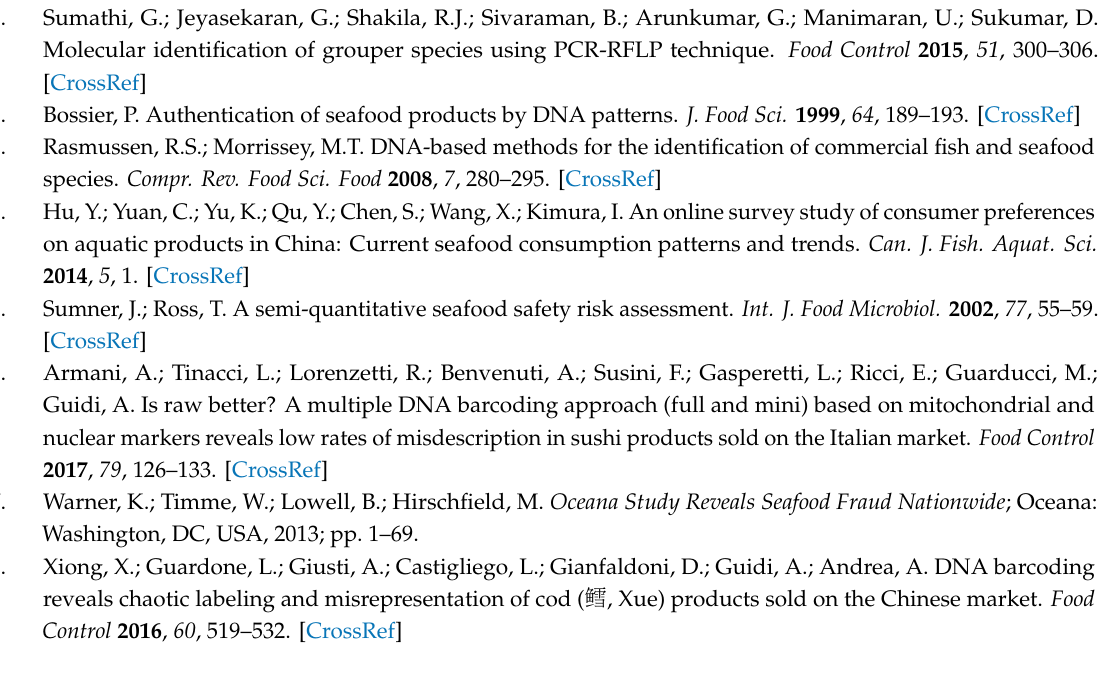
Table S1: The sequence of the specificity SNPs, Table S2: The Chinese denominations of common codfish samples in the Chinese